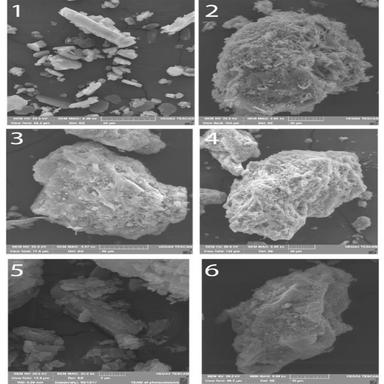
SEM images of compounds: 1) Fe(OPD)2SO4(1); 2) Co(OPD)2SO4; 3) Fe (MPD)2SO4(2); 4) Co(MPD)2SO4(3); 4) Fe(PPD)SO4 (4); and 6) Co(PPD)SO4 (5). The material Co(OPD)2SO4 is added to give complete view of the trend of the relations between the dimensionality and morphology.